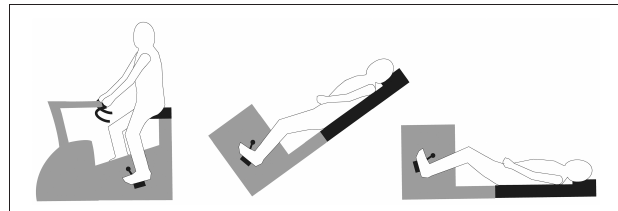
FIGURE 1 | Illustration of the three different cycling